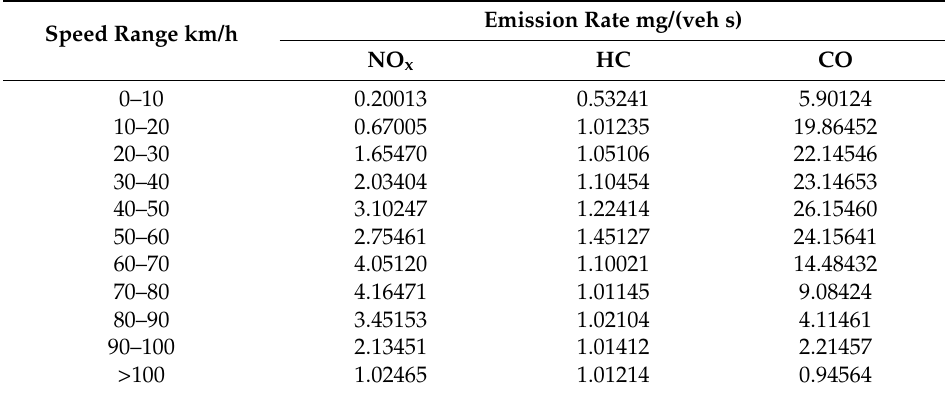
Table 1. Relationship between driving speed and emission rate [47].